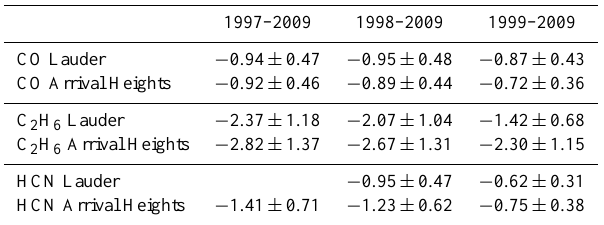
Table 2. Summary of trends and 2 σ uncertainties of CO, C 2 H 6 , and HCN partial columns at Lauder and Arrival Heights for various periods. Units are in %yr − 1